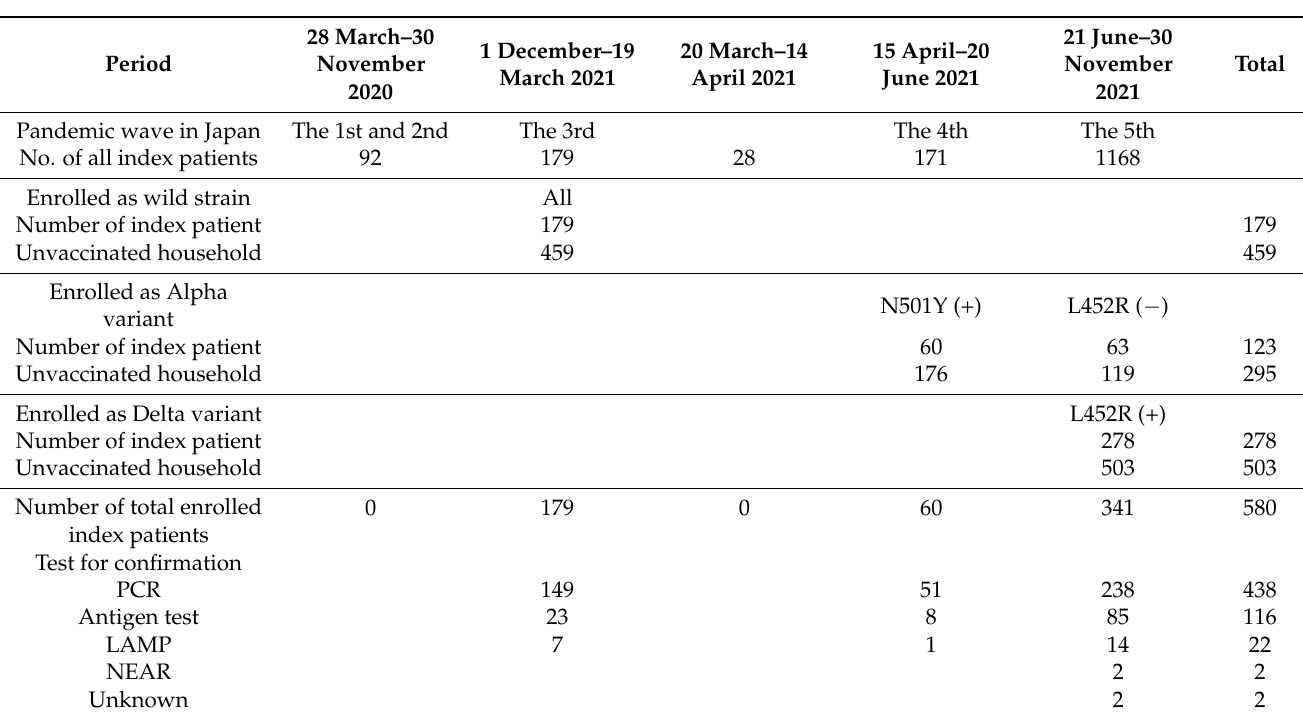
Table 1. Period, flow of enrollment of index cases, including test for confirmation, and house- hold contacts.